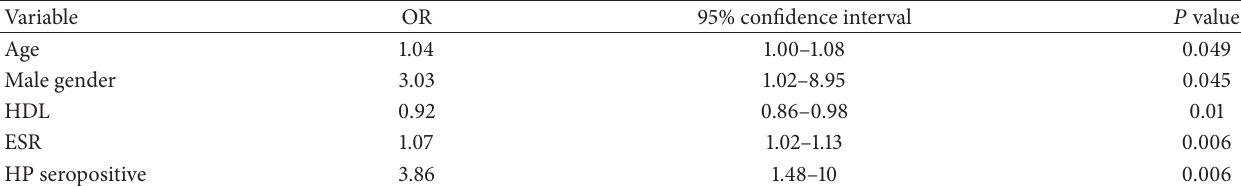
Table 3: Influence of patient’s basic characteristics and biochemical parameters on presence of disease based on linear logistic